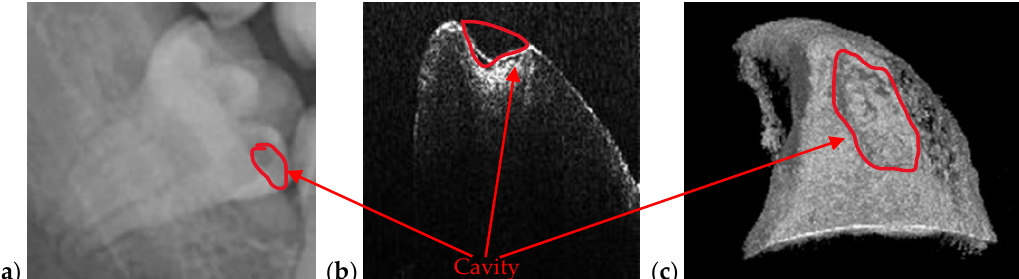
Figure 7. ( a ) Cavity of a third molar from the fourth quadrant assessed on a section cropped from a panoramic radiography. OCT investigation on the tooth extracted for medical purposes after performing the radiography: ( b ) B-scan and ( c ) 3D reconstruction. Patient E.M., male, age 23 years, diagnosed with a cavity on the smooth surface (lateral side) of the third molar, with the following remarks on the clinic condition: the cavity appeared because the third molar is not in a correct position and in that area, between the second and the third molar, the patient cannot perform a full cleaning of the tooth.